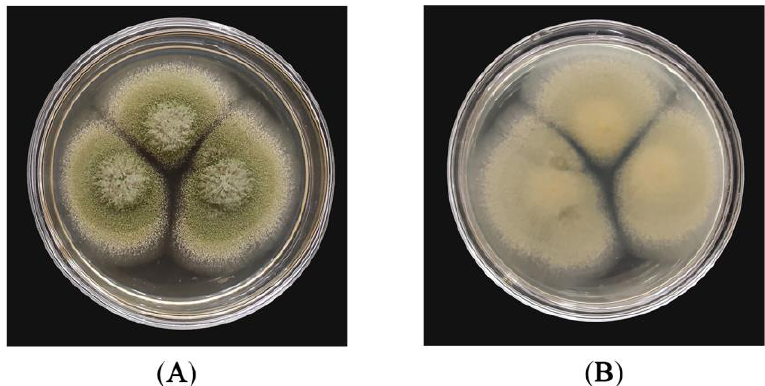
Figure 1. Morphological characteristics of strain YQM: ( A ) front side; ( B ) back side.